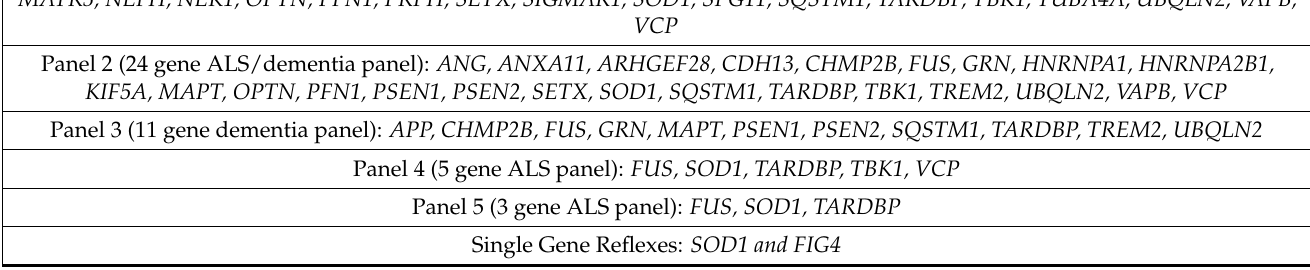
Table 1. Multigene sequencing panels performed in the tested cohort. Panel 1 (28 gene ALS/dementia panel): ALS2, ANG, ATXN1, CHCHD10, CHMP2B, DCTN1, ERBB4, FIG4, FUS, HNRNPA1, KIF5A,